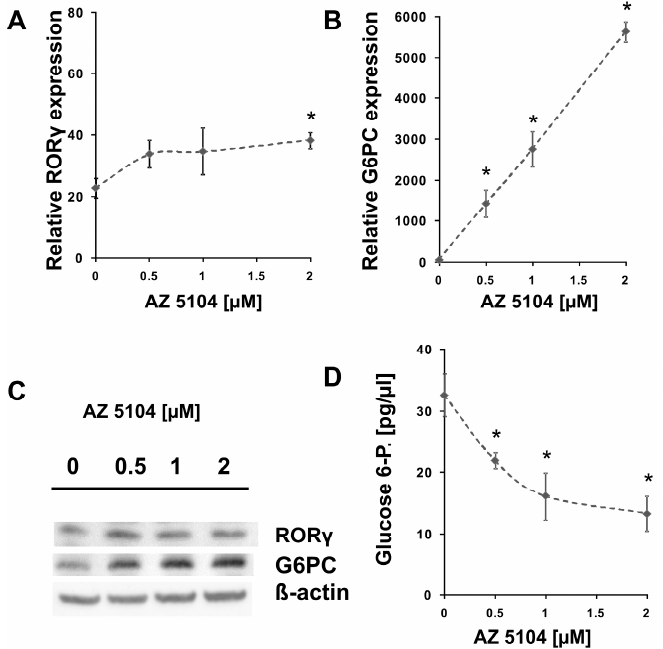
Figure 4. Effect of AZ5104 on the mRNA expression of ROR γ ( A ) and G6PC ( B ) in HepG2 cells. HepG2 cells were treated with increasing concentrations of AZ5104 for 24 h and then collected for RNA extraction. The mRNA expression of ROR γ and G6PC was determined by real-time RT-PCR and normalized to that of the housekeeping genes HPRT1 , HMBS, and RPL13A . Mean ± SD, n = 3. * p < 0.05 compared with control cells. ( C ) Effect of AZ5104 on the ROR γ and G6PC proteins in HepG2 cells as determined using Western blotting. ( D ) Effect of AZ5104 on the glucose 6-phosphate levels in HepG2 cells. Mean ± SD, n = 3. * p < 0.05 compared with control cells.